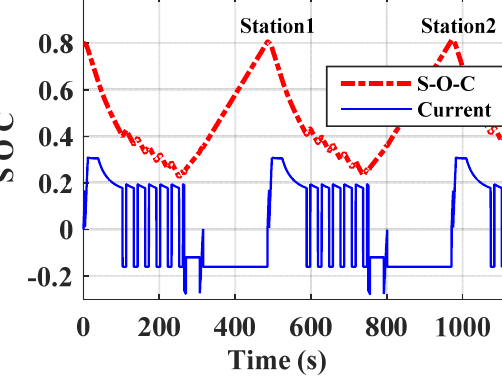
Figure 17. Ultracapacitor state of charge with actual load profile scaled.